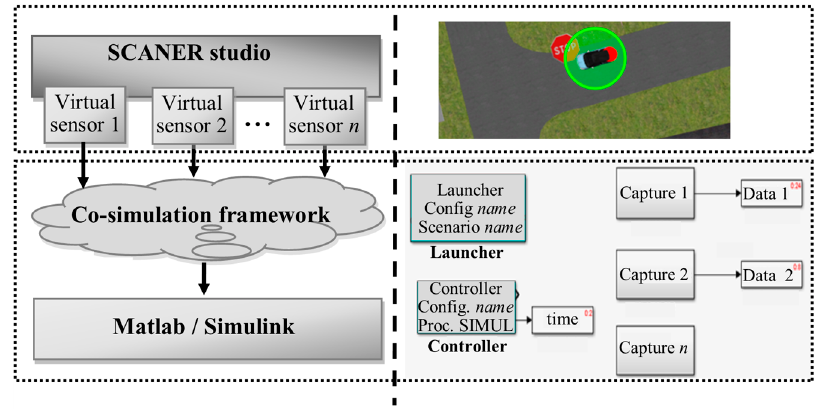
Figure 2. Co-simulation framework architecture.